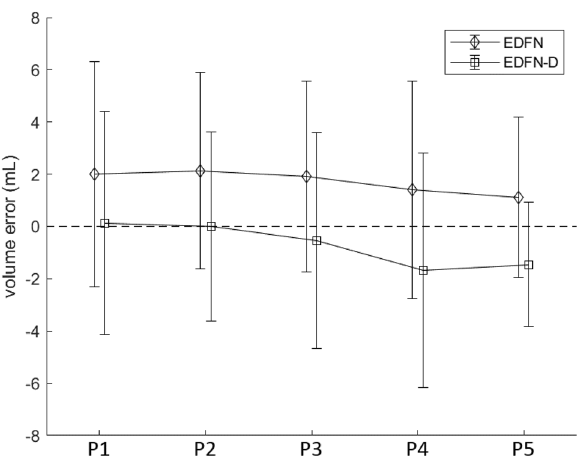
Figure 5. Volume error of the modified texture dataset, in millilitres, of our proposed method without (EDFN) and with (EDFN-D) depth-refinement compared to the volume across the ground-truth hand segmented food area. P1 is the reference plate with P2-P5 representing simulated degrees of increasing intake (i.e., P5 most